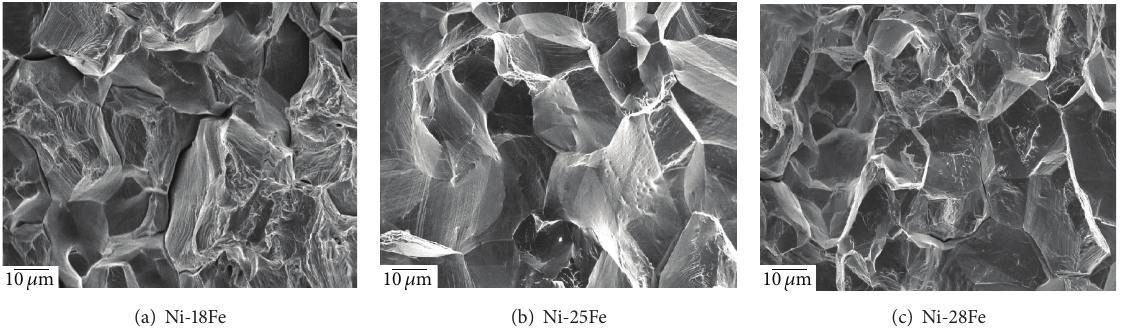
Figure 7: SEM fractographs of the ordered Ni 3 Fe with different stoichiometry when tested in H 2 .